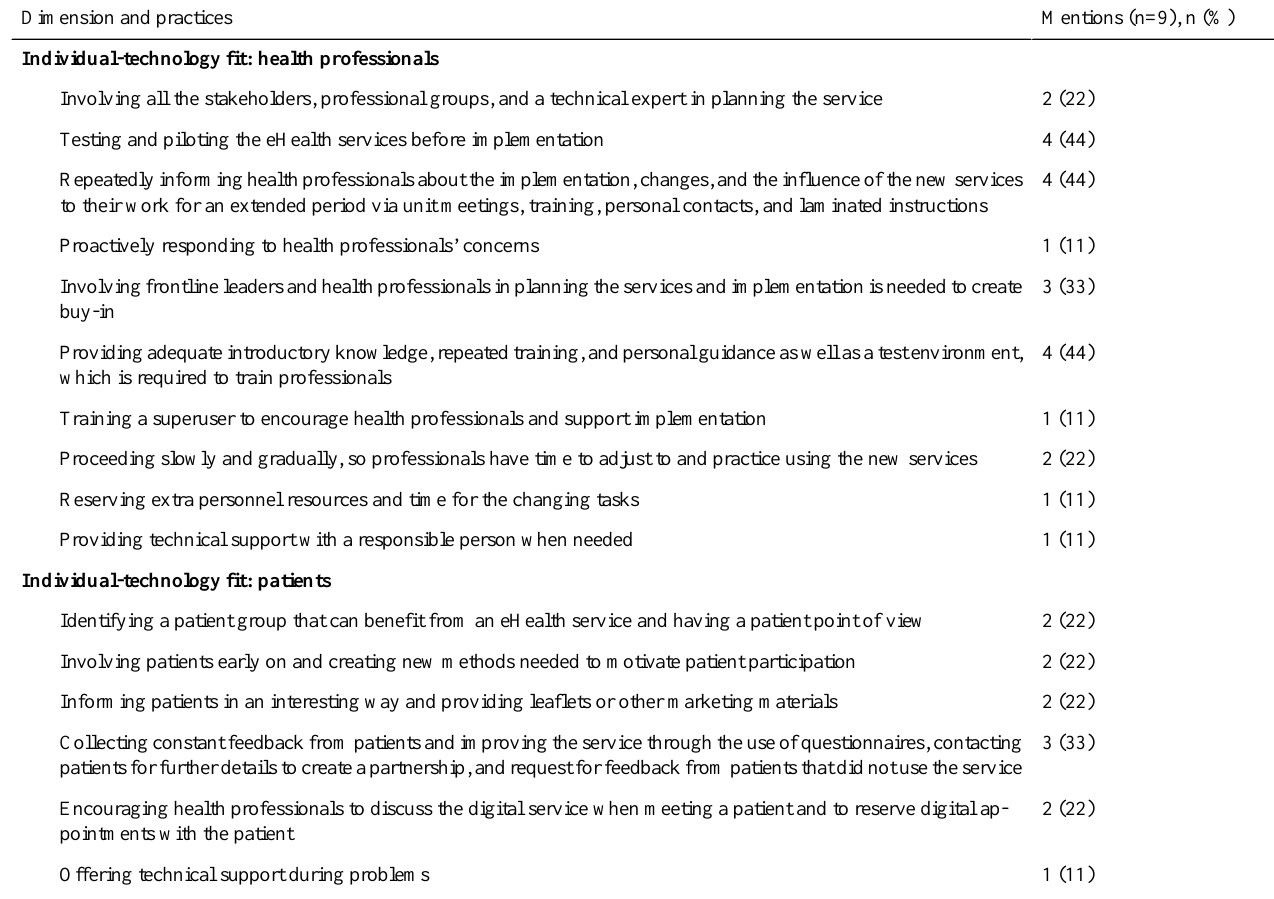
Table 4. Practices for managing the challenges of